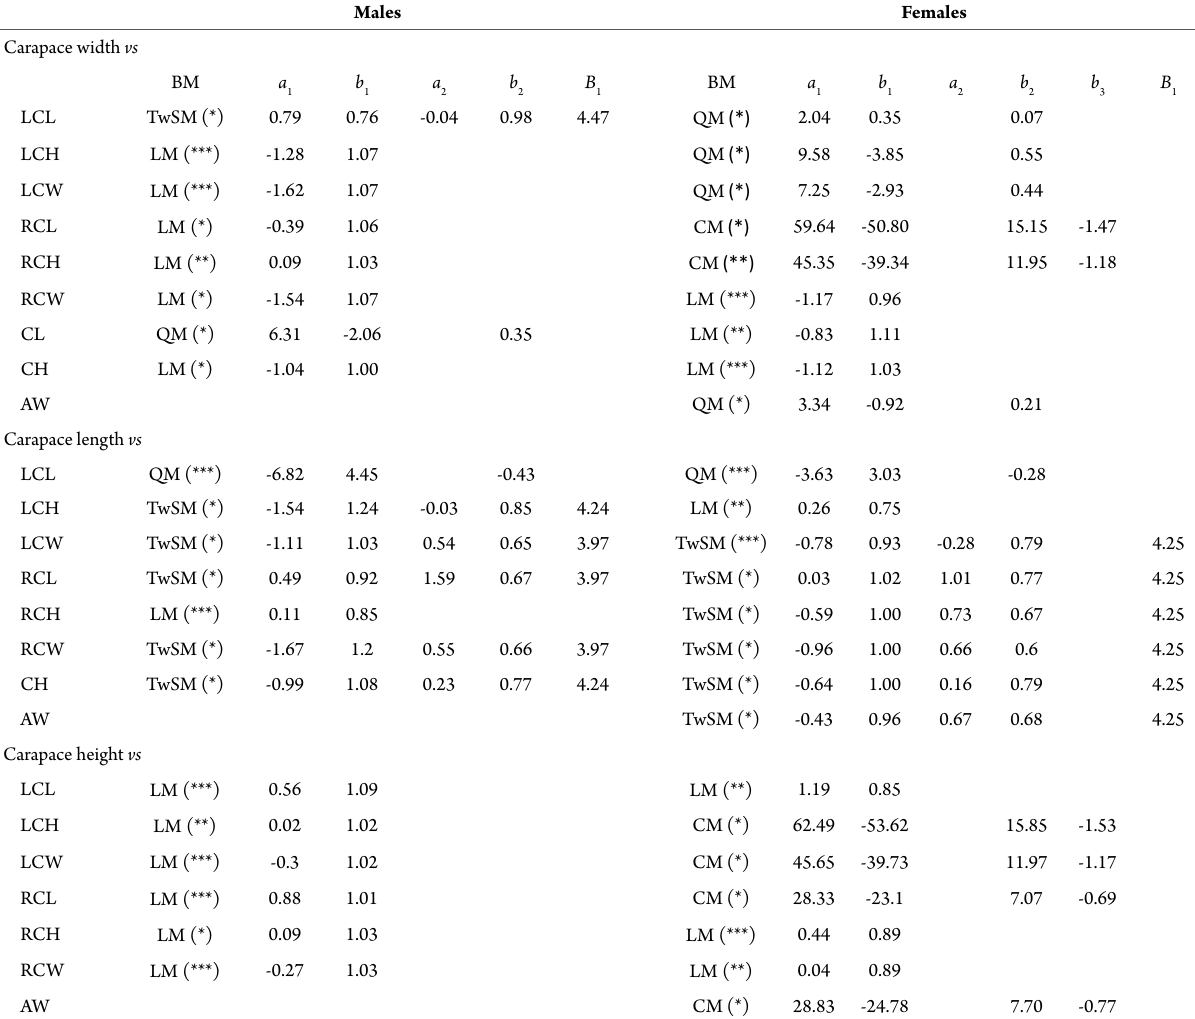
Table 2. Parameters of the best models (BM) selected based on the criteria i (*) , ii (**) and iii (***) for the morphometric relationships of Menippe frontalis in the Gulf of Guayaquil, Ecuador. LCL, left chelae length; LCH, left chelae height; LCW, left chelae width; RCL, right chelae length; RCH, right chelae height; RCW, right chelae width; CW, carapace width; CL, Carapace length; CH, carapace height; AW, abdomen width. LM, linear model; QM, quadratic model; CM, cubic model; TwSM, two segment model. Males